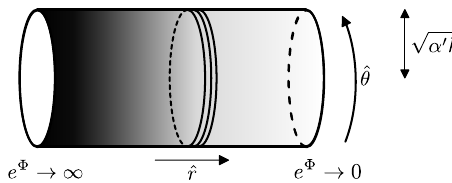
Figure 14. The sine-Liouville background. According to the FZZ duality, the sine-Liouville sigma-model is a dual description of the SL(2 , R ) k / U(1) CFT, better suited when k − 2 is small. √ The geometry is an infinite cylinder of radius α 0 k . The dilaton is Φ = − Q ˆ r , so that the string coupling e Φ diverges as ˆ r → −∞ and vanishes as ˆ r → ∞ . The sine-Liouville